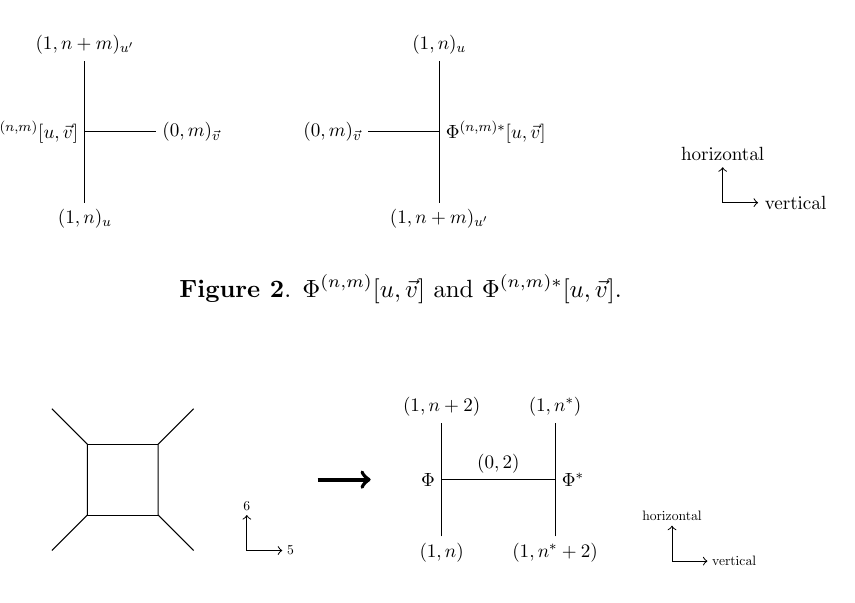
Figure 3 . ( p; q )-brane web diagram of A 1 U(2) quiver gauge theory (left) and the corresponding web of DIM representations